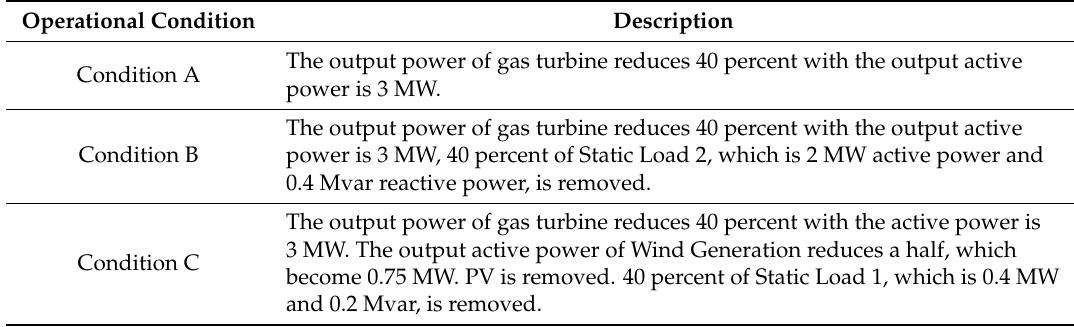
Table 4. Describe of operational conditions.